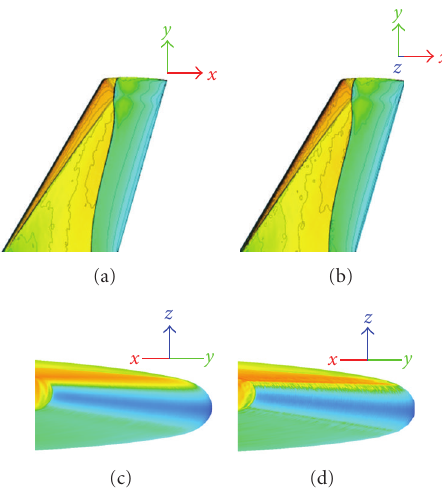
Figure 29: Iso-Mach lines and solution ( M ∞ ), with detail of the leading edge, after a second adaptation step on the ONERA M6 wing with (left) and without (right) projection.